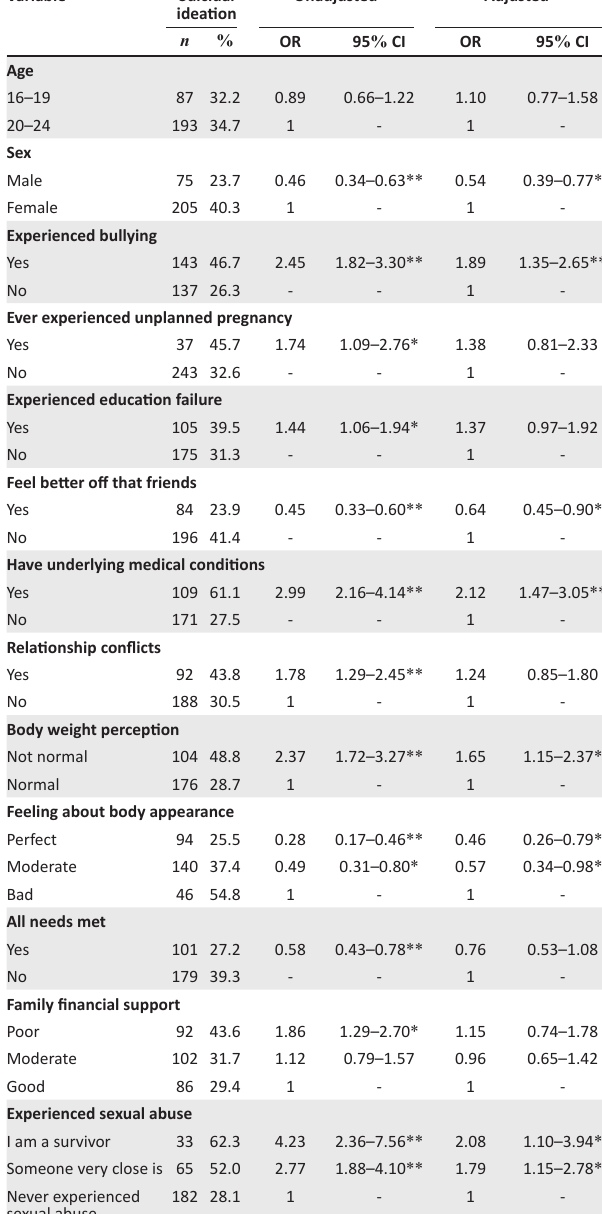
TABLE 1: Background characteristics of respondents stratified by sex. Variables